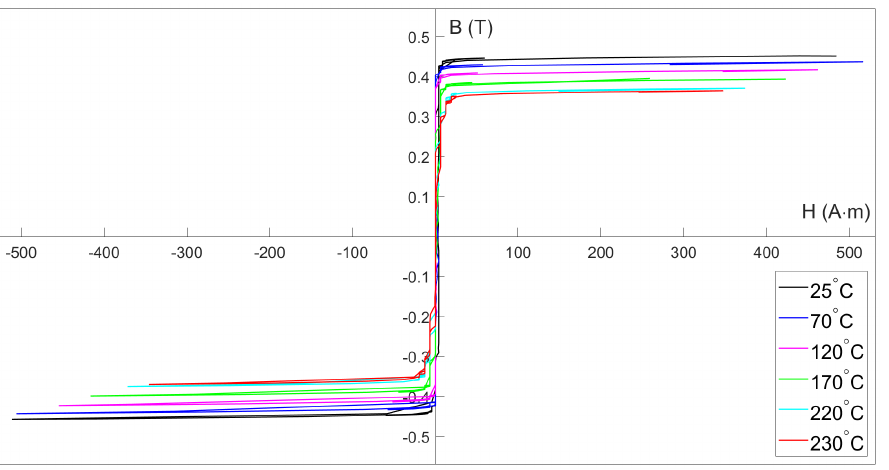
Figure 6. Hysteresis loop of the magnetic core measured at different temperatures at 1kHz. Different colors indicate different sensor temperature.